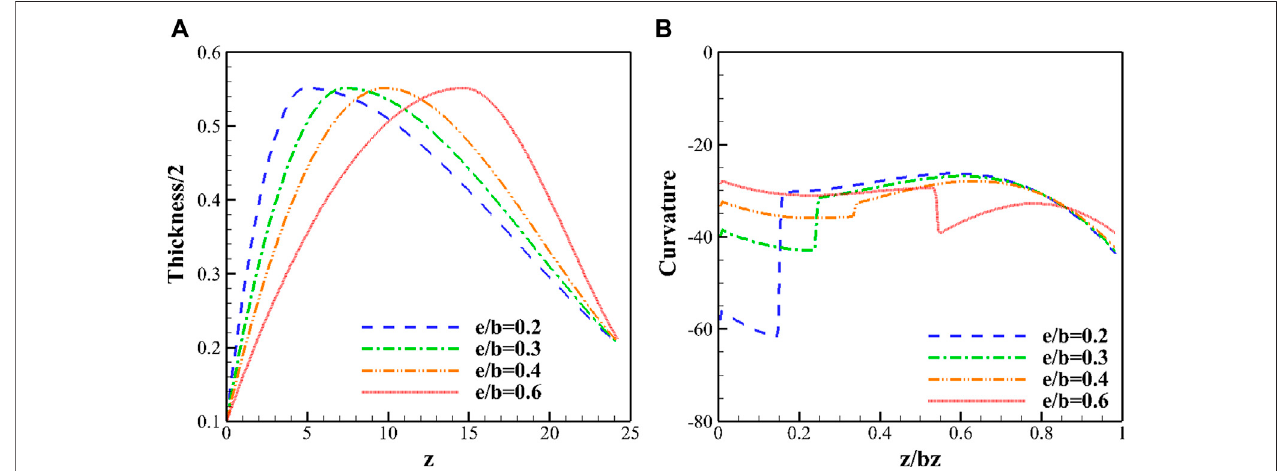
FIGURE 3 | Axial distribution of pro fi le thickness (A) and the curvature of suction side (B) .